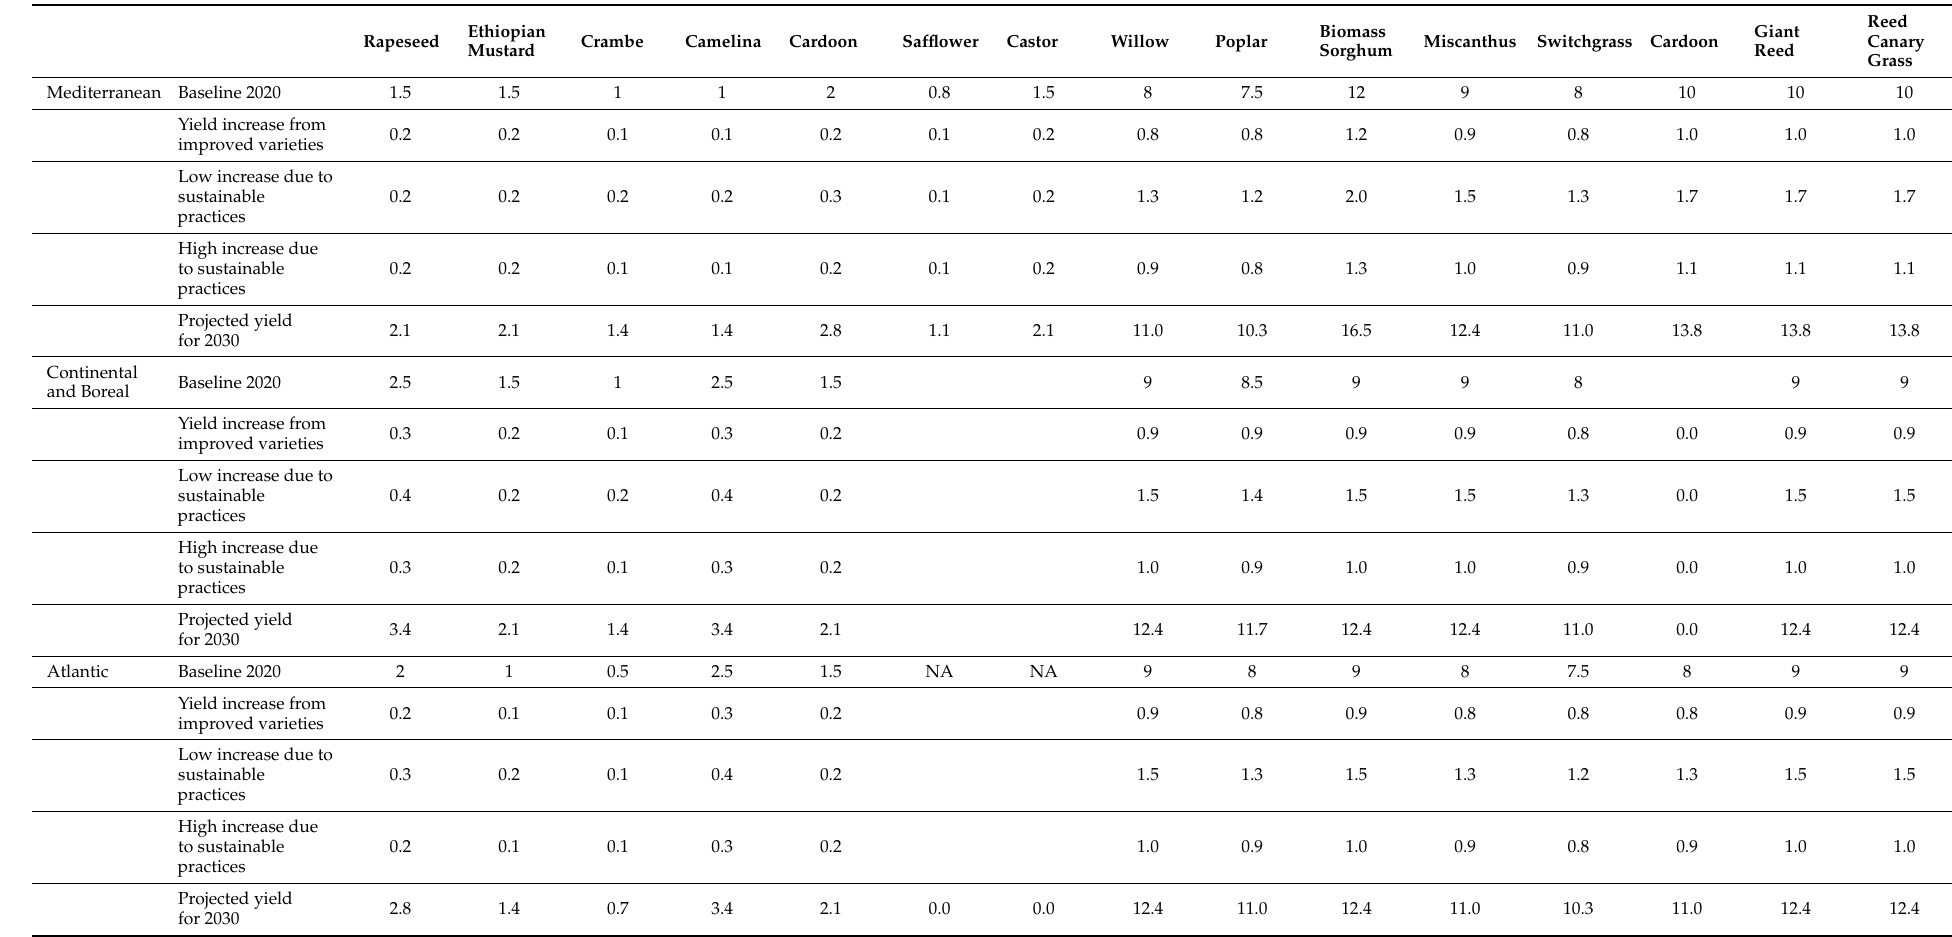
Table A2. Observed attainable yields and potential yield increases of the understudy crops in land with natural constraints. Rapeseed Ethiopian Mustard Crambe Camelina Cardoon Safflower Castor Willow Poplar Biomass Sorghum Miscanthus Switchgrass Cardoon Giant Reed